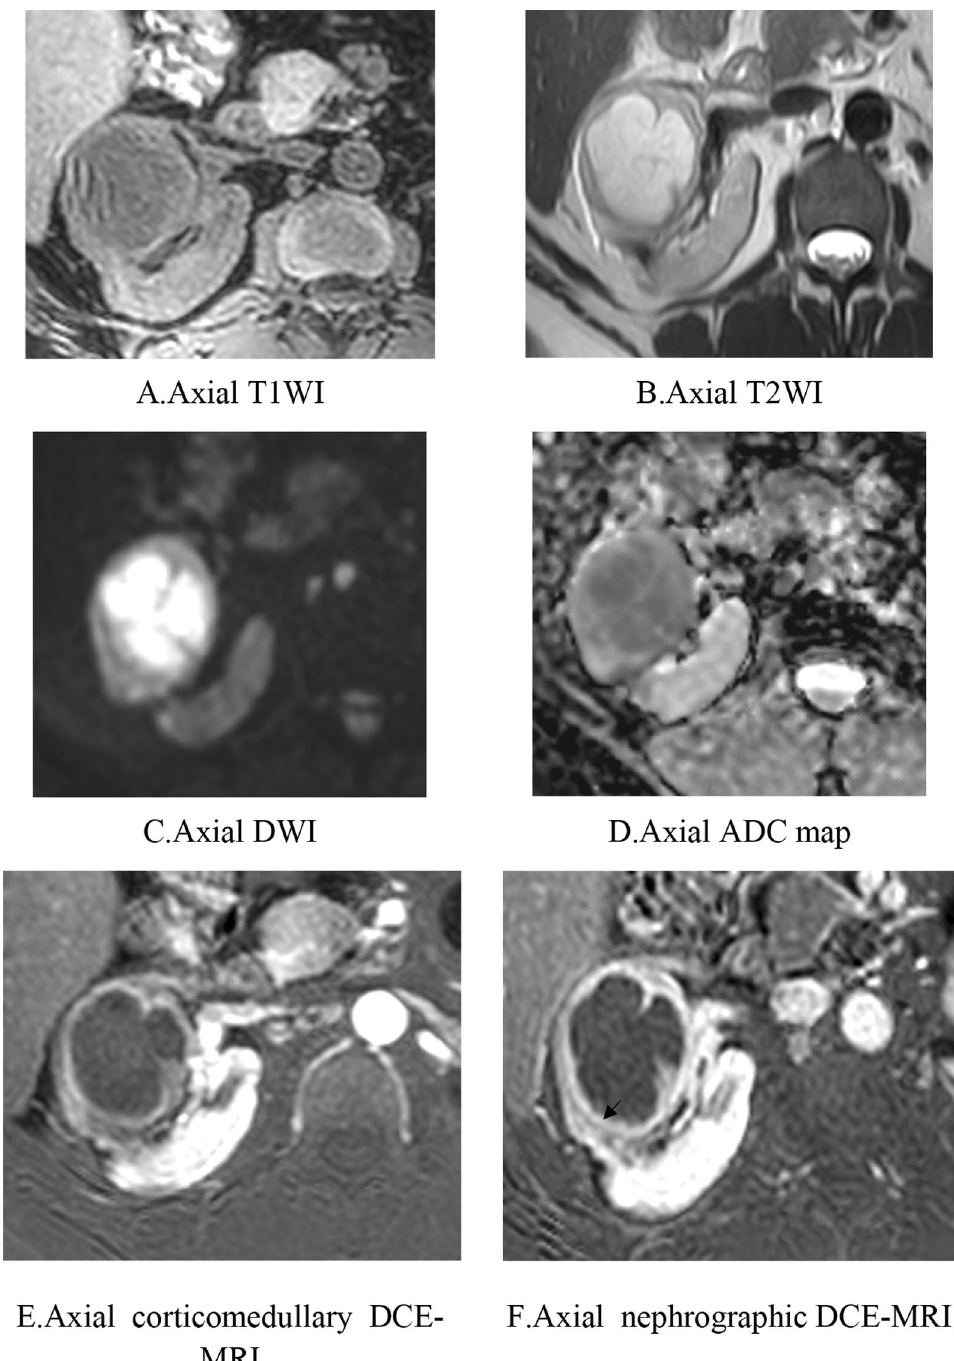
Fig. 8 Right renal cyst (Bosniak III). Axial T1WI ( A ) showed a well‑defined right midzonal exophytic thick‑walled parenchymal multilocular cystic lesion measuring 4.7 cm in its maximum dimension. The lesion is hypointense with thick incomplete septae of intermediate signal inside. Axial T2WI ( B ) the lesion appears hyperintense with intermediate signal of the septae. Axial DWI b 800 mm 2 /s & axial ADC map ( C , D ) Showed restricted = content, no restriction of the wall or septae. Axial corticomedullary and nephrographic DCE‑MRI subtracted images ( E , F ) showed smooth thick enhancing wall (4 mm) (arrow) septae. The pathology/cytology: Pus by percutaneous drainage tube